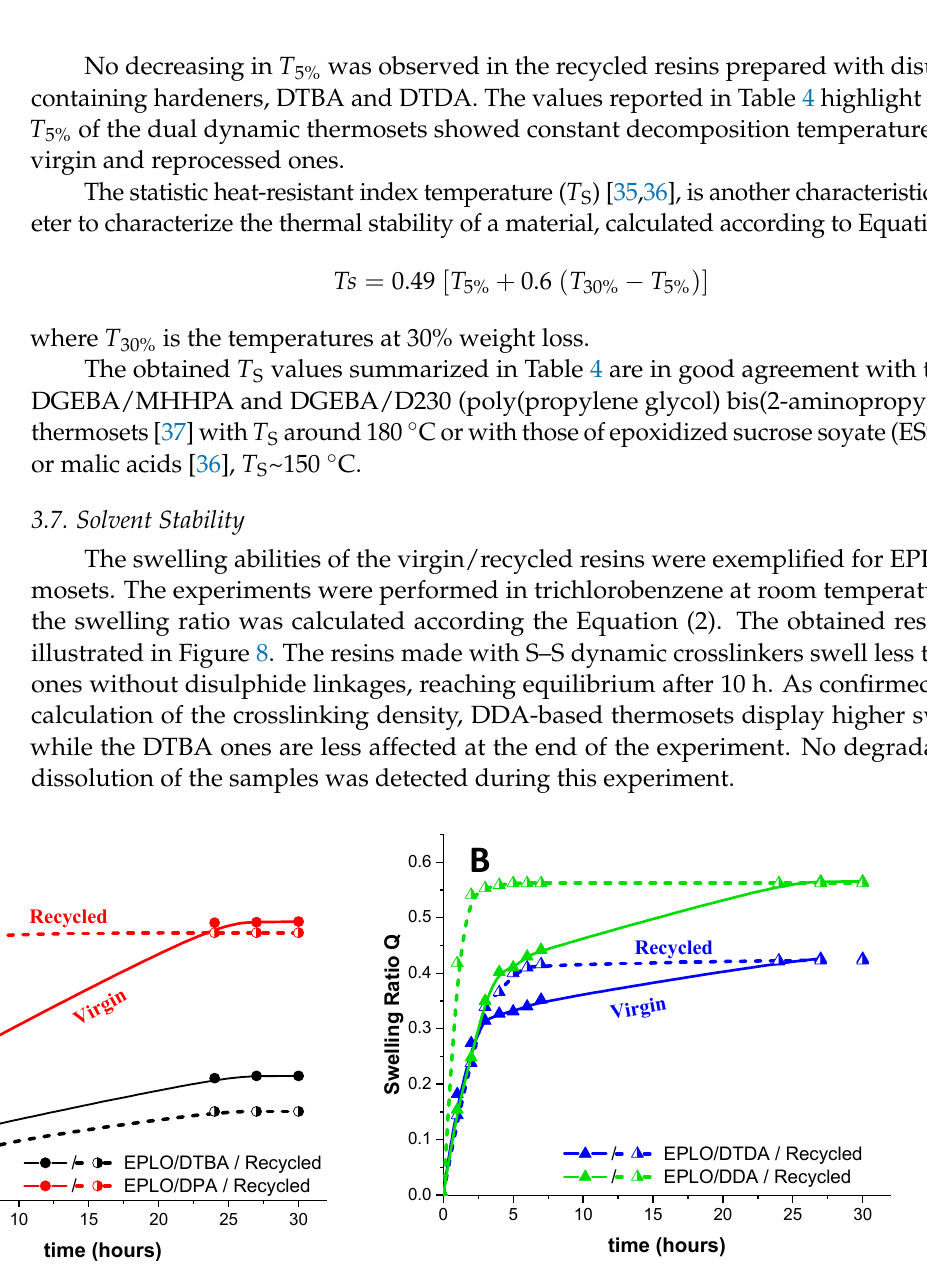
Figure 8. Swelling experiments in trichlorobenzene for the virgin and recycled EPLO thermosets prepared with ( A ) aromatic (DTBA and DPA) and ( B ) aliphatic (DTDA and DDA) crosslinkers.